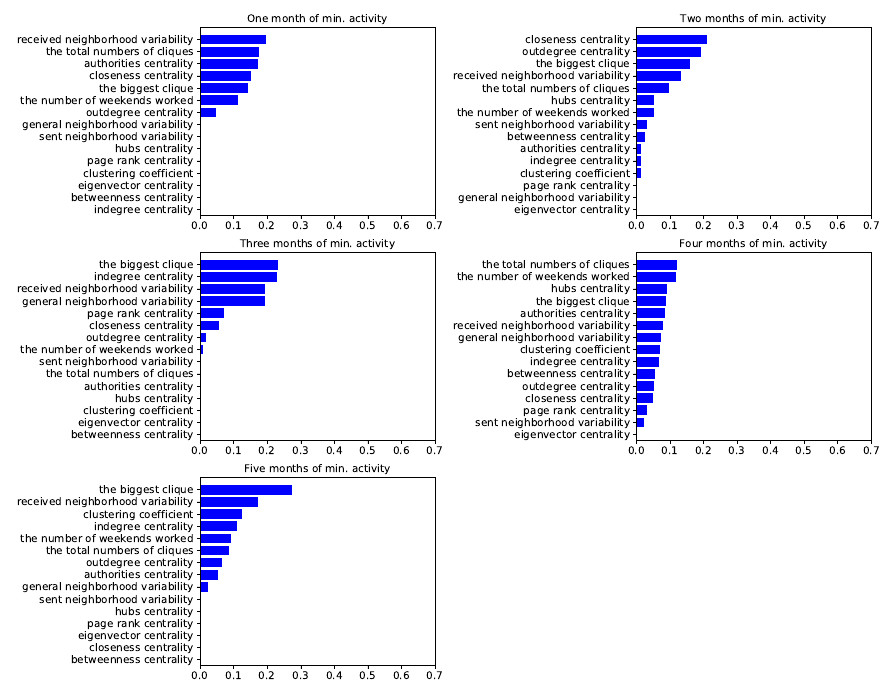
Figure A9. Features importance (Gini importance) for the Random Forest which uses the full set of features for the Enron dataset with two levels of the hierarchy.